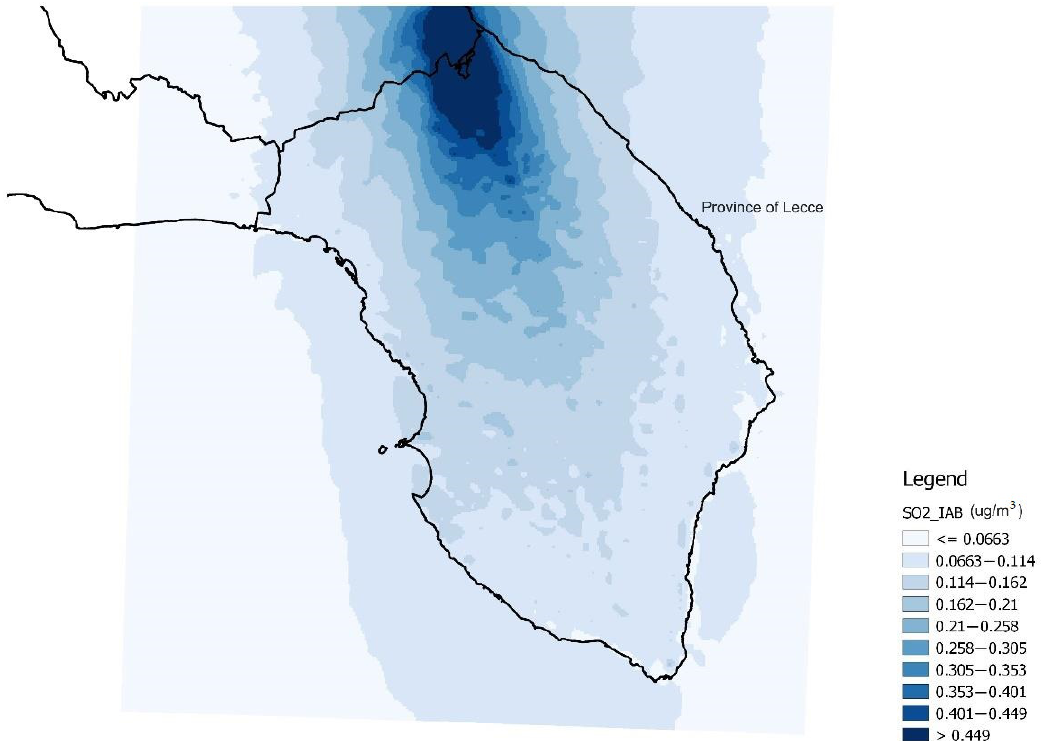
Figure 2. Spatial distribution of sulfur dioxide concentrations emitted by the plants included in the Industrial Area of Brindisi (IAB) (SO 2 _IAB) (data in µg/m 3 from 1993).